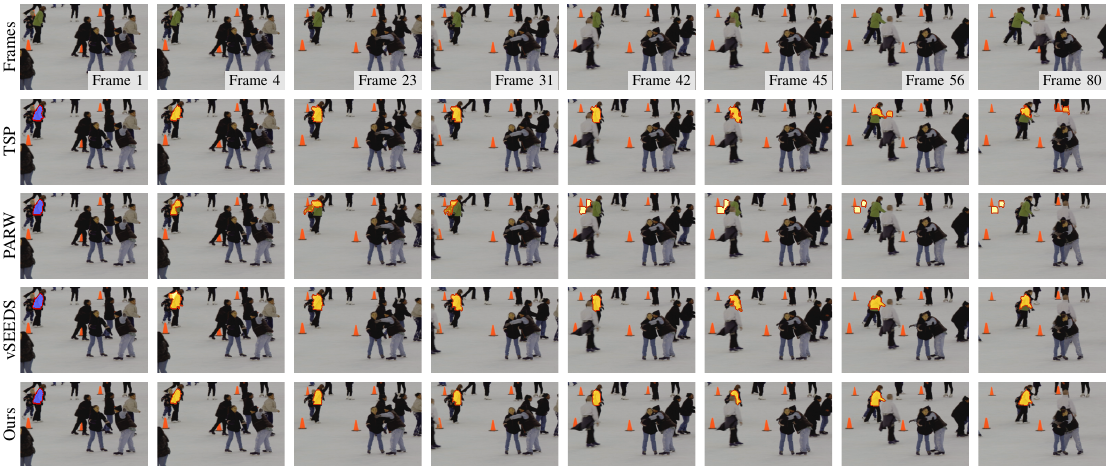
Figure 10. Segmentation results of a moving target that is partially covered by another object during the moving.